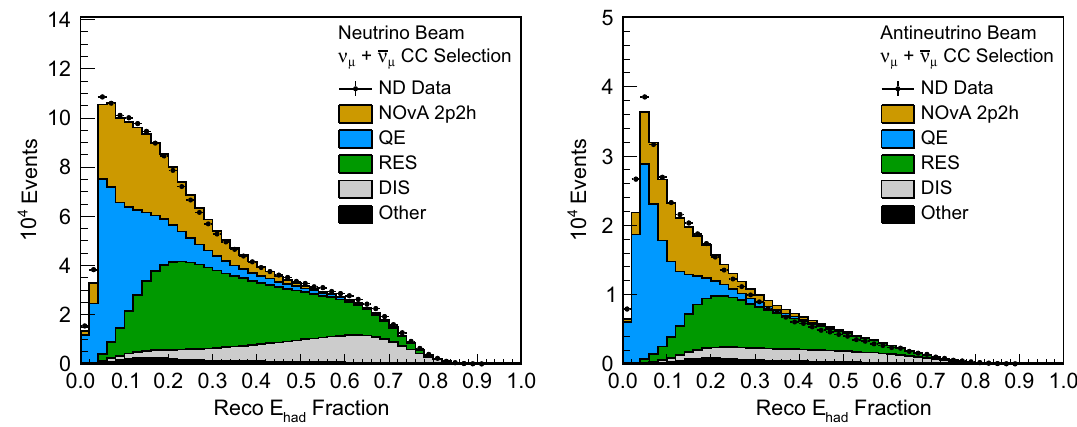
Fig. 18 Comparison of fully adjusted simulation to data in reconstructed hadronic energy fraction, for neutrino beam (left) and antineutrino beam